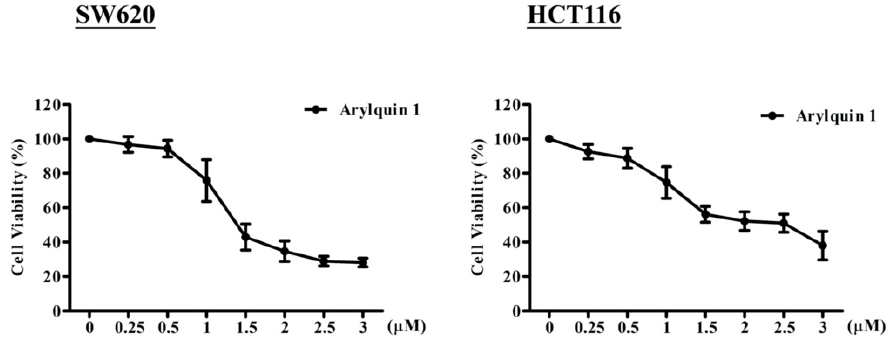
Figure 1. Viability of SW620 and HCT116 cells treated with different doses of Arylquin